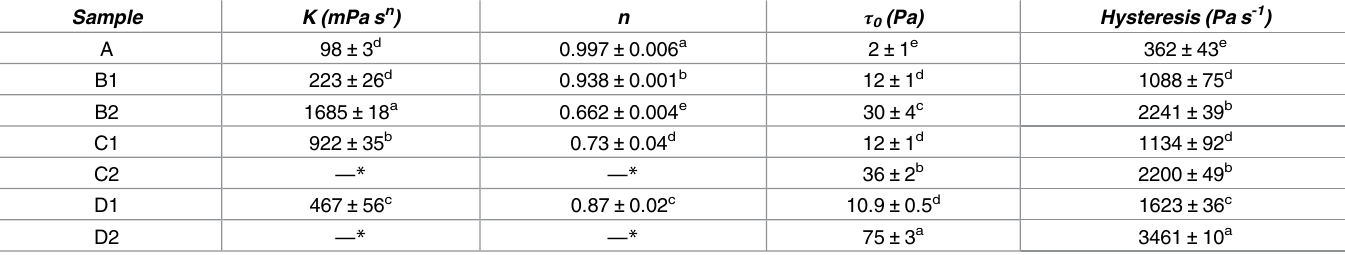
Table 5. Rheological parameters of yogurt samples with and without curdlan and submitted or not to heat treatment. Hysteresis, consistencyindex (K), flow behavior index (n) and yield stress ( τ 0 ). Valuesindicate mean ± standard-deviation.